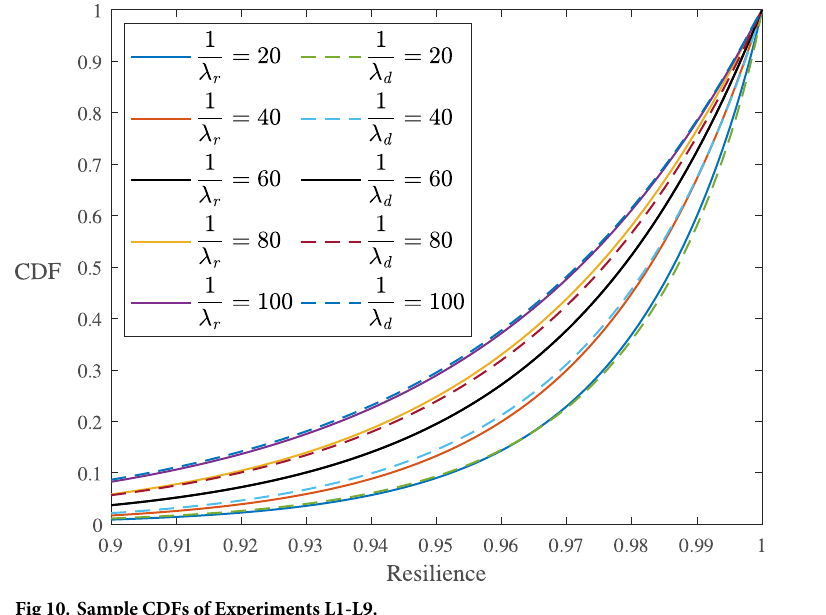
Fig 10. Sample CDFs of Experiments L1-L9.